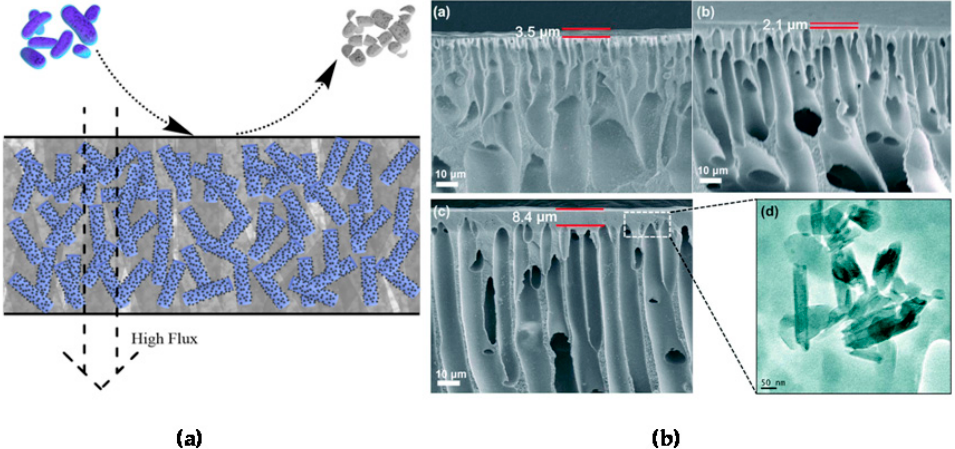
Figure 9. ( a ) General scheme of a filtration membrane with antibacterial halloysite based fillers. ( b ) SEM images of the cross-section morphology of membranes: ( a ) pure polyethersulfone membrane, ( b ) polyethersulfone membrane containing 1% N -halamine@halloysite, and ( c ) polyethersulfone membrane containing 3% N -halamine@ halloysite; ( d ) TEM image of the presence of N-halamine@halloysite in the polyethersulfone hybrid membrane. Reproduced with permission from [113], Royal Society of Chemistry, 2015.